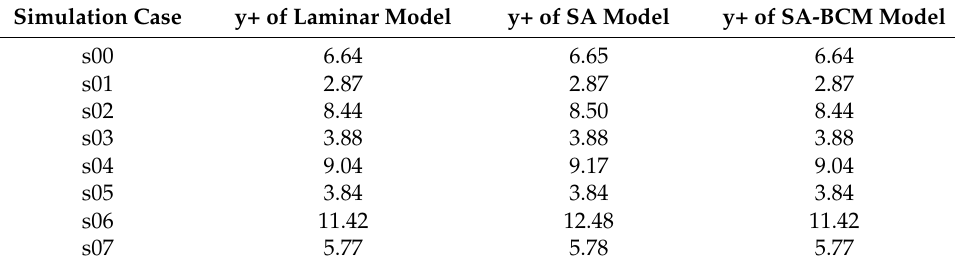
Table 8. y+ of the first cell over the flat plate in each